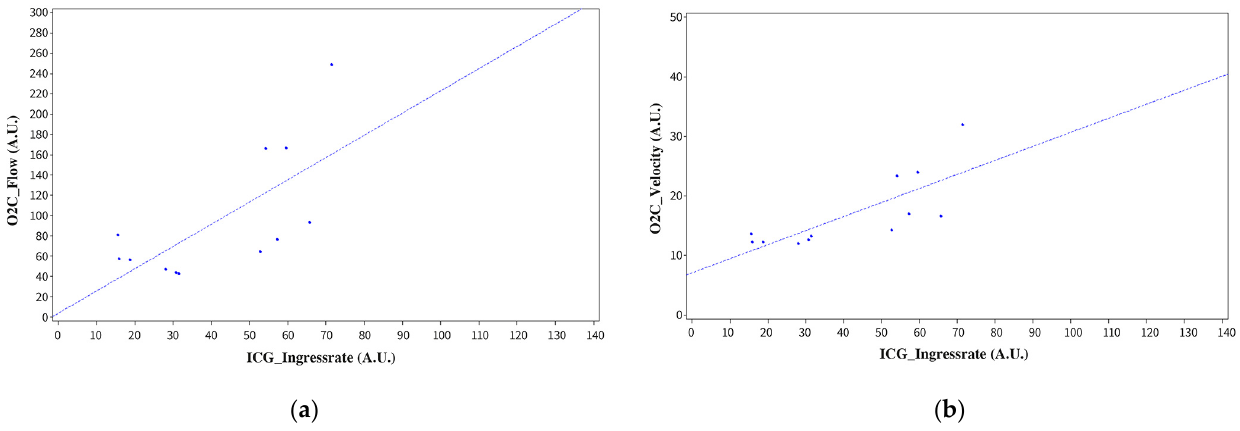
Figure 3. ( a ) Correlation of microvascular flow determined by O2C with ICG IngressRate (r = 0.69319, p = 0.0124). ( b ) Correlation of microvascular velocity determined by O2C with ICG IngressRate (r = 0.76678, p = 0.0036).